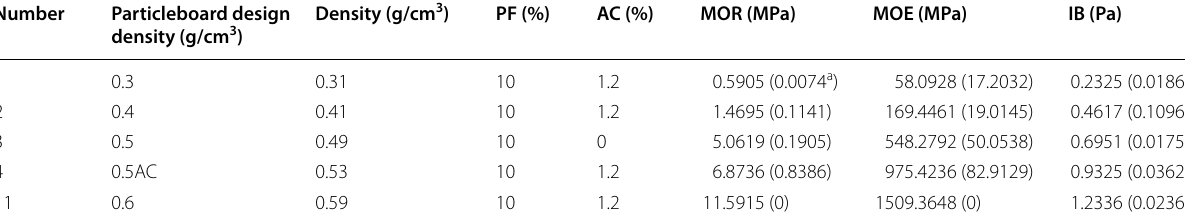
a ND: the content in brackets is the standard deviation of the results of several repeated experiments